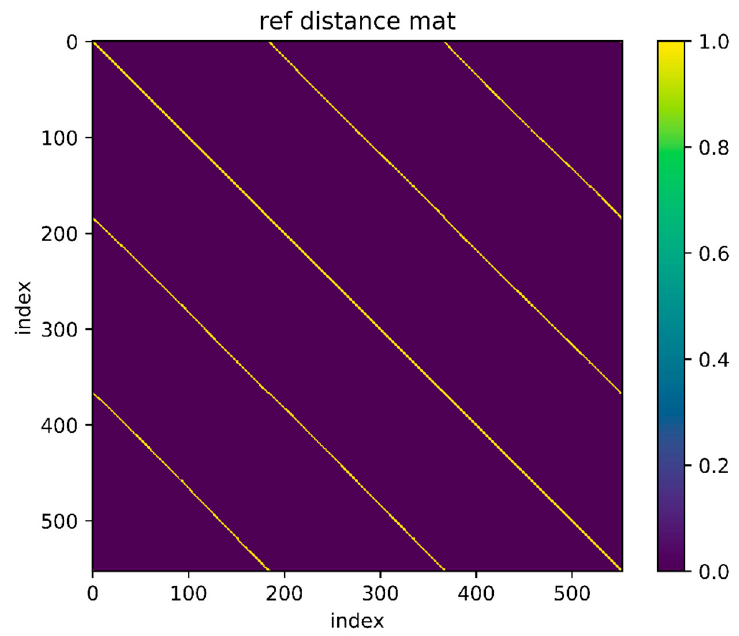
Figure 3. Reference distance in position space.